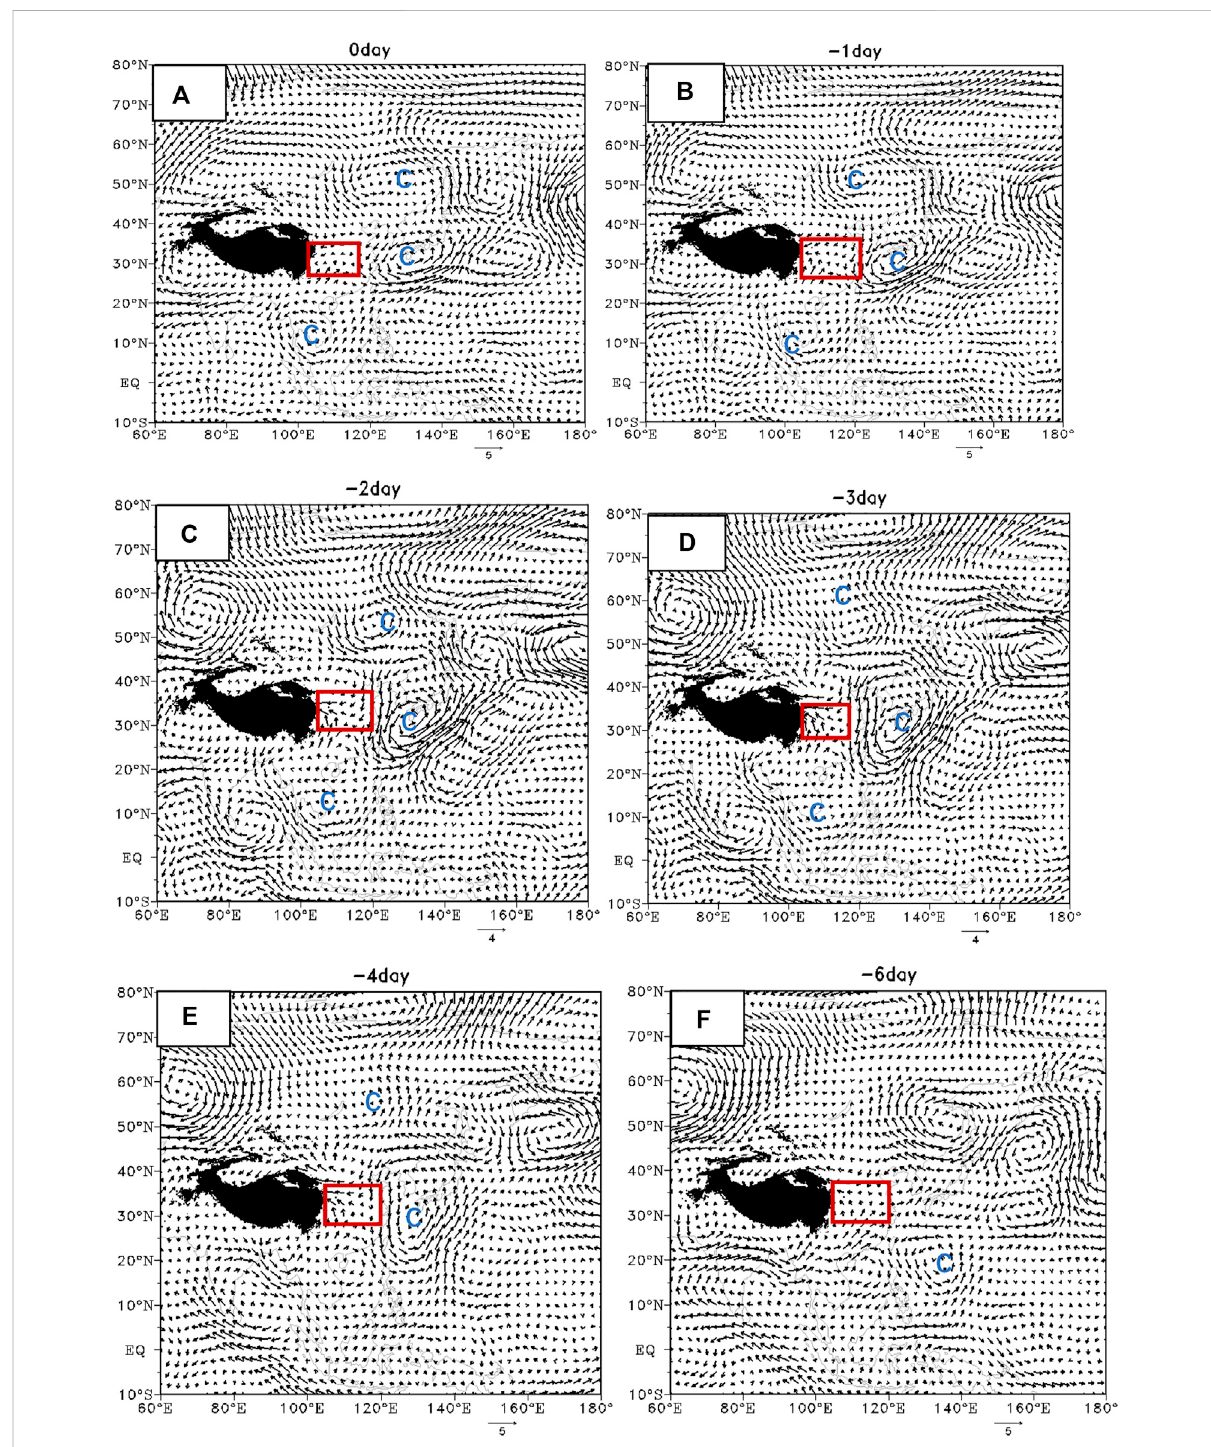
FIGURE 4 Evolutionofthelow-frequency(15 – 30 days)wind fi eldsat850 hPafrom6 daysbeforetheprecipitationto0 dayafteronsetinEasternSichuan, unit: